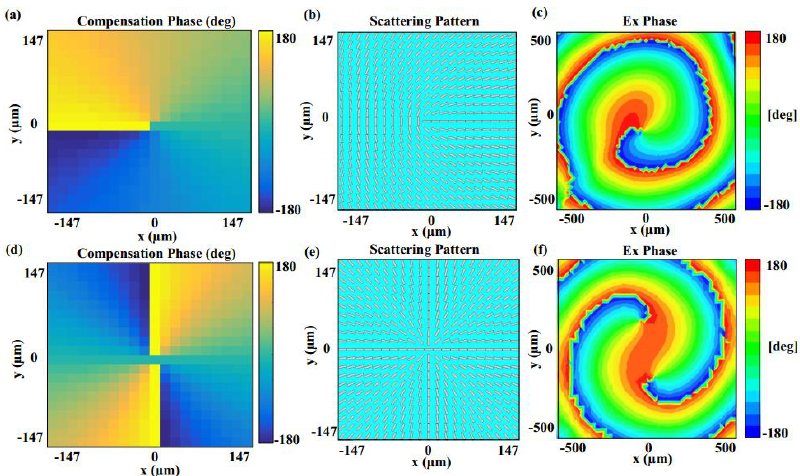
Figure 8. Simulation results with different topological charges: ( a – c ) The required compensation phase distribution, scattering pattern of the proposed metasurface and Ex phase distribution for the case L = 1; ( d – f ) the required compensation phase distribution, scattering pattern of the proposed metasurface and Ex phase distribution for the case L = 2.